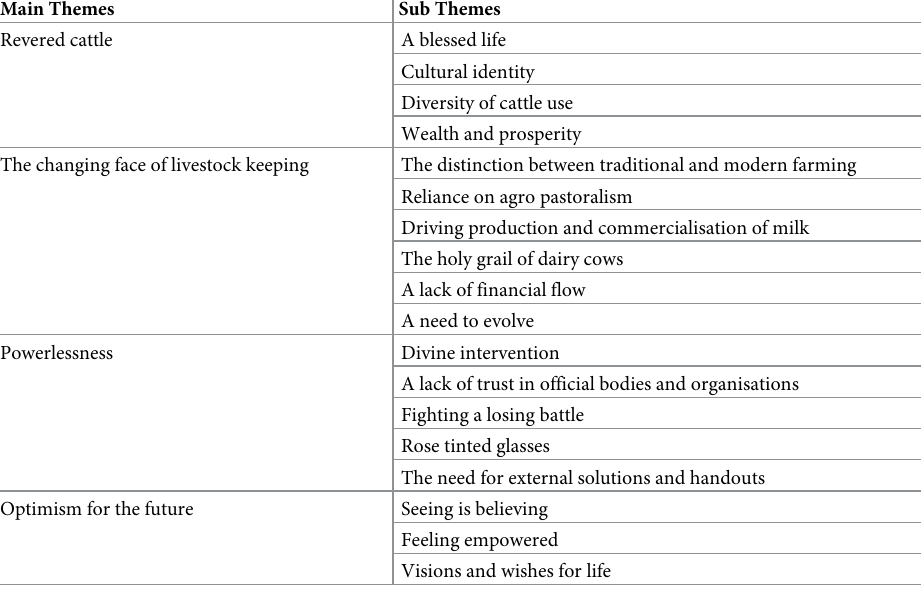
Table 2. Interpretive themes developed through thematic analysis of focus groups